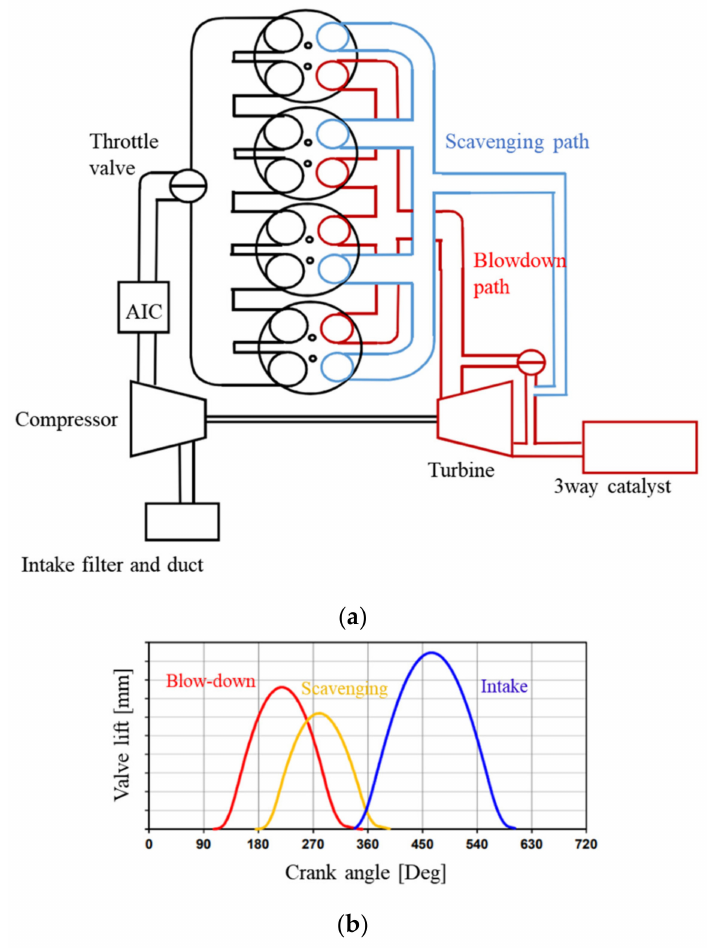
Figure 1. ( a ) Schematics of DEP engine configuration; ( b ) example of valve